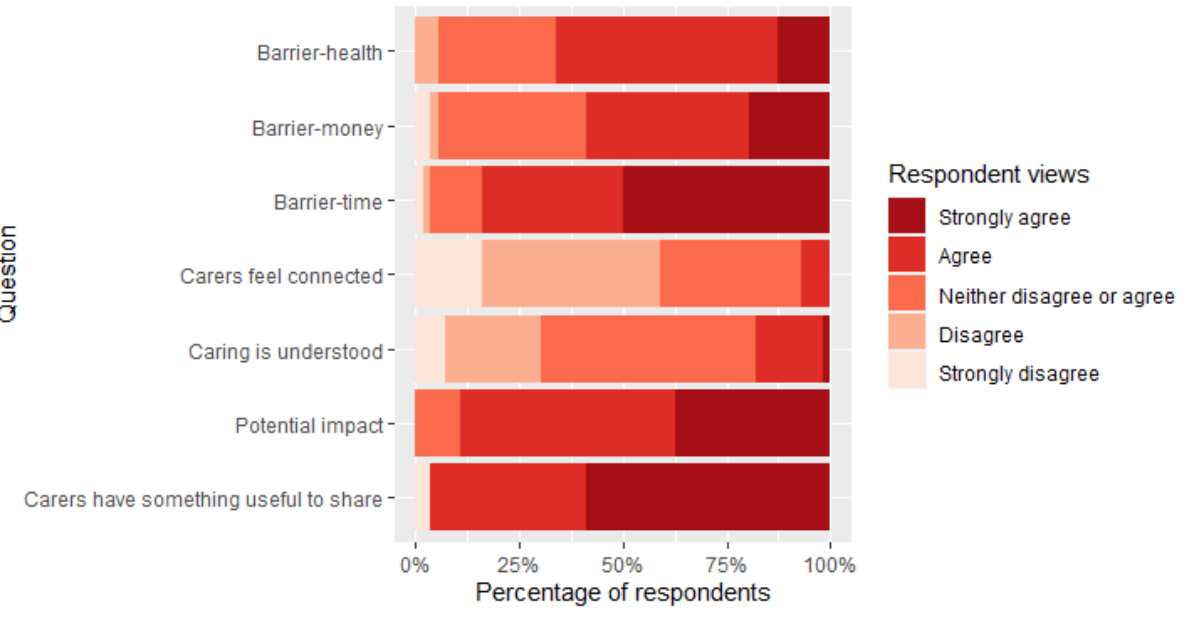
Figure 3. Professionals’ responses to a range of statements according to whether they “Strongly agree”, “Agree”, “Neither disagree or agree”, “Disagree” and “Strongly Agree”. Statements focused on whether: (i) caregivers have something useful to share with researchers, (ii) researchers could make potential impact on caregiver health and wellbeing, (iii) the role of a caregiver is understood, and (iv) whether caregivers feel connected to researchers at university settings. In addition, we explored views on the barriers of (v) time, (vi) money and (vii) health to participation in research.